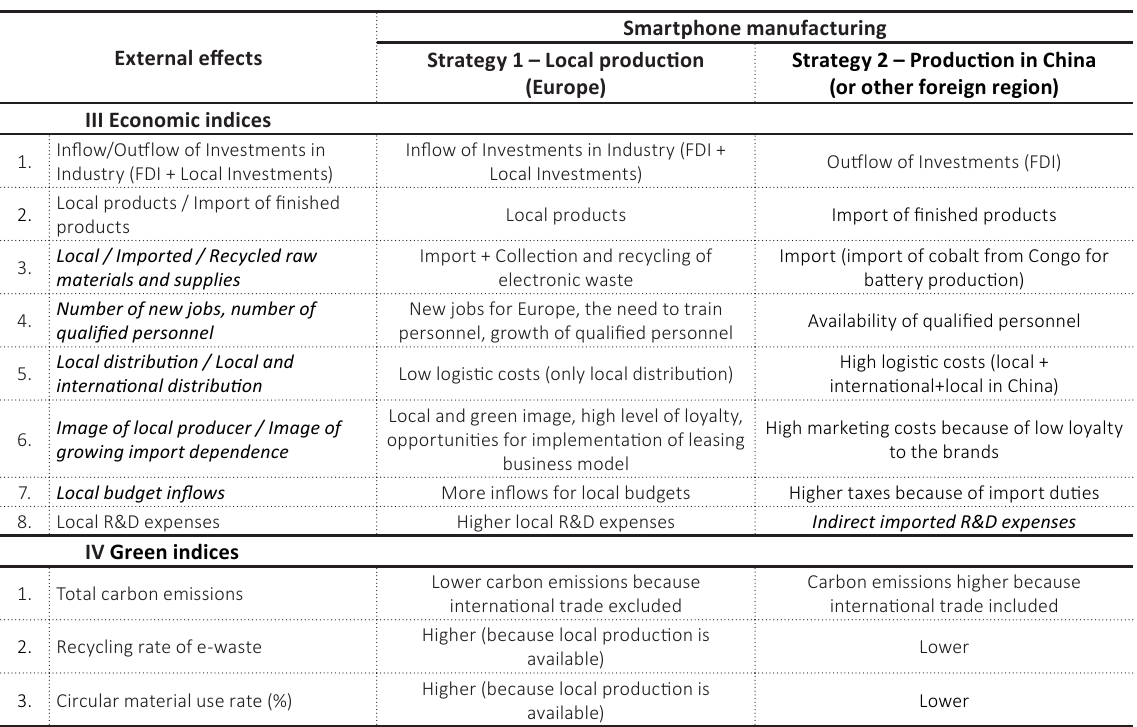
Source: Developed by the